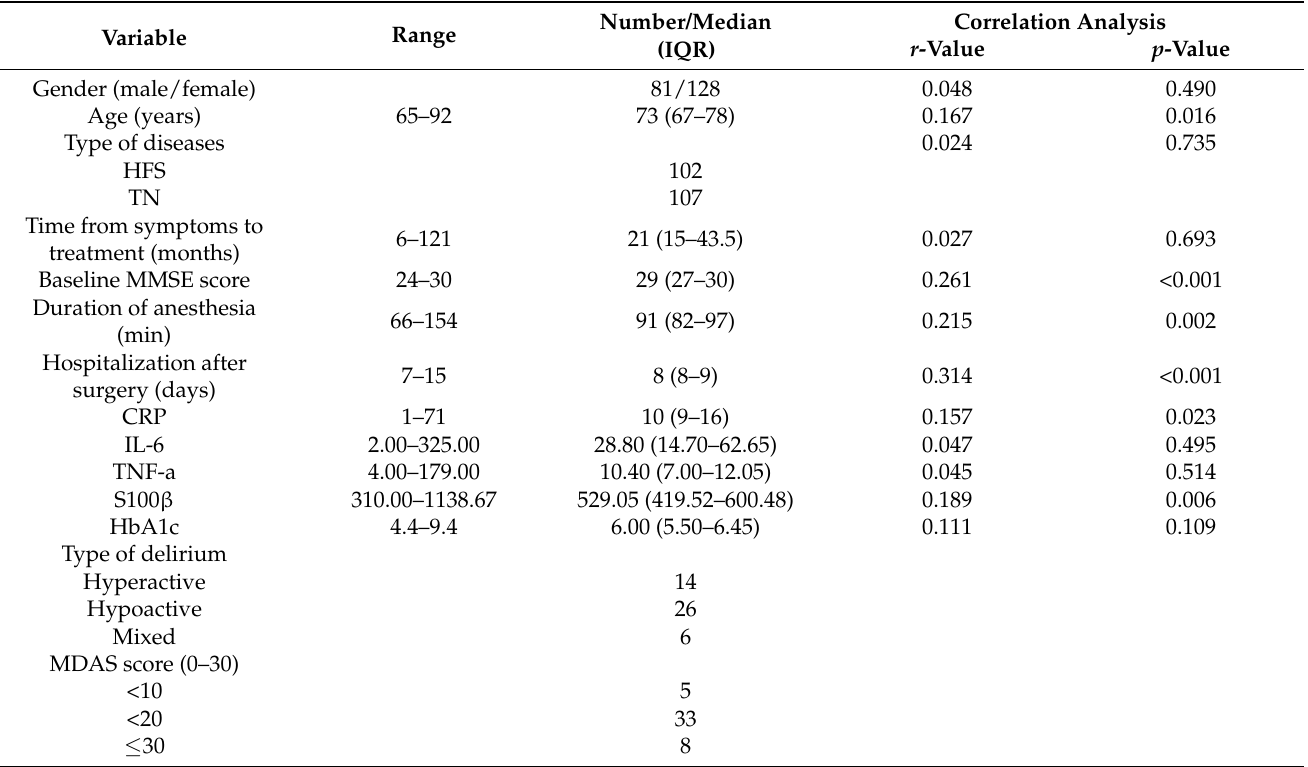
Table 1. Clinical characteristics and laboratory examinations and parameters correlated with serum NSE levels after MVD in older